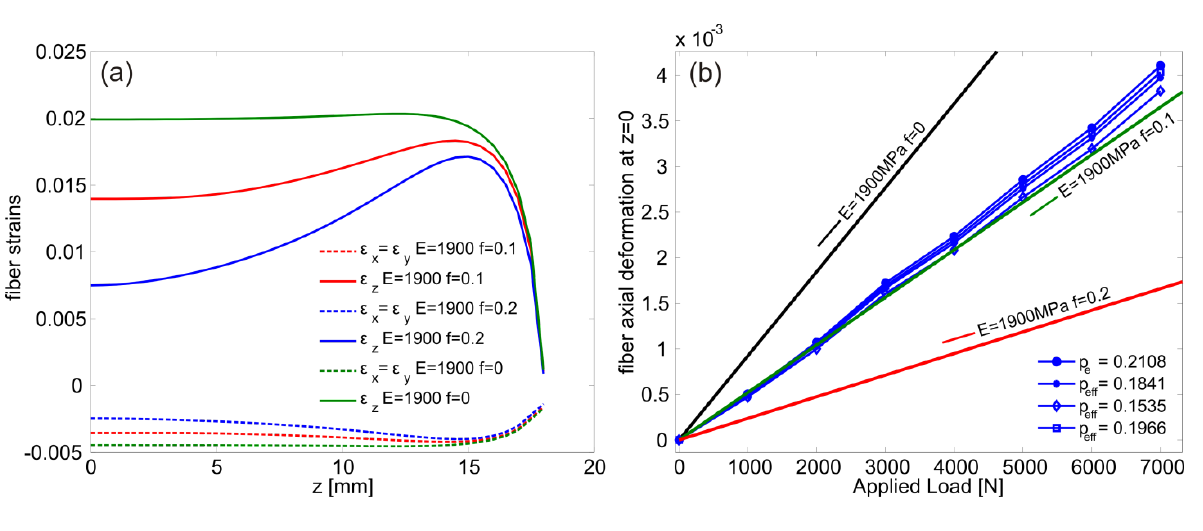
Figure 4. ( a ) Simulated axial and lateral deformations of the sensor in terms of z , ( b ) simulated axial strains at the specimen’s center with different friction coefficients between epoxy block and grips compared to experimental data shown by the blue